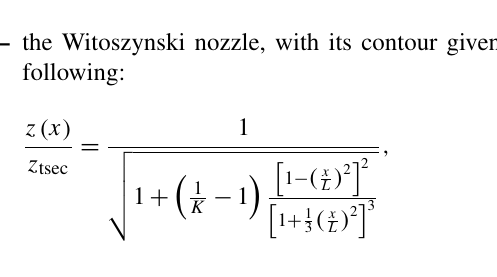
Figure 6. Spray system for low MVD and low LWC, and its supply